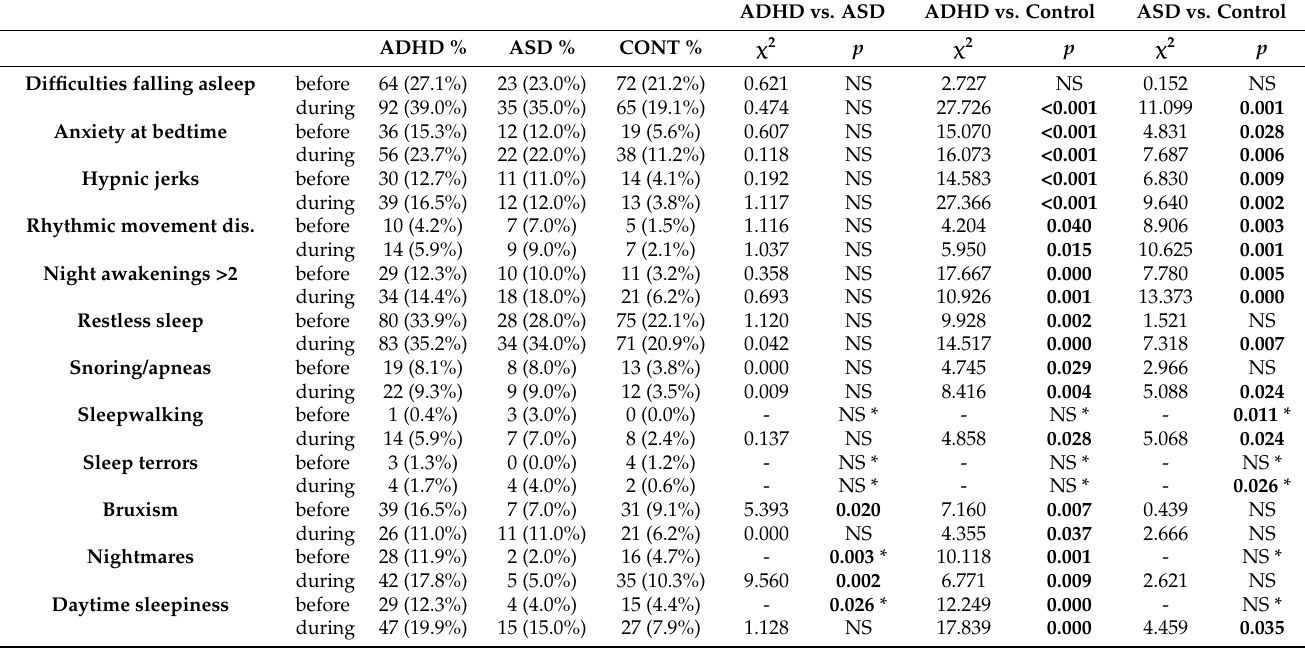
Table 7. Comparison of sleep disorders before and during lockdown in the three groups. ADHD vs. ASD ADHD vs.